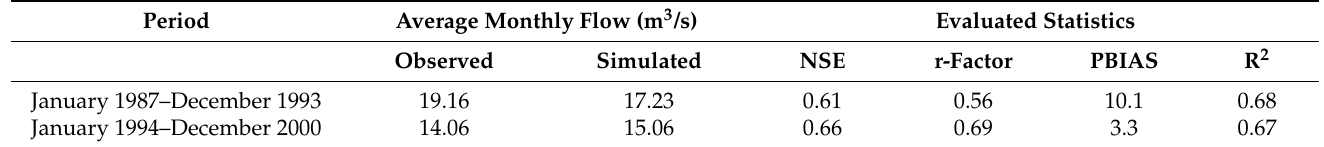
Table 3. Model performance statistics for the calibration and validation periods.